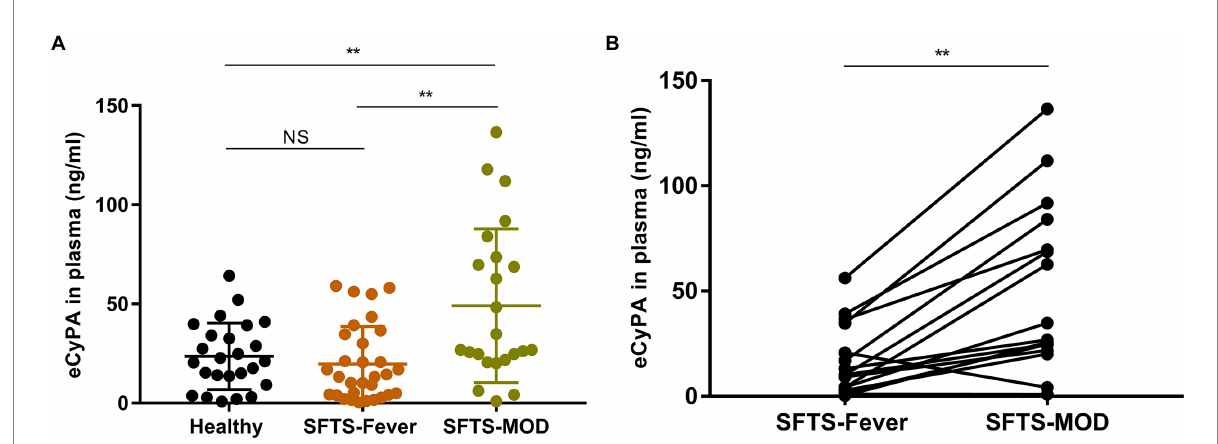
FIGURE 1 Expression pattern of Cyclophilin A (CyPA) in the plasma of SFTS patients. (A) Plasma CyPA detection levels as measured by ELISA in 29 healthy subjects and 30 SFTS patients. (B) Paired analysis of changes in the expression of CyPA in the plasma of 16 SFTS patients between the febrile and MOD phases. ** p <